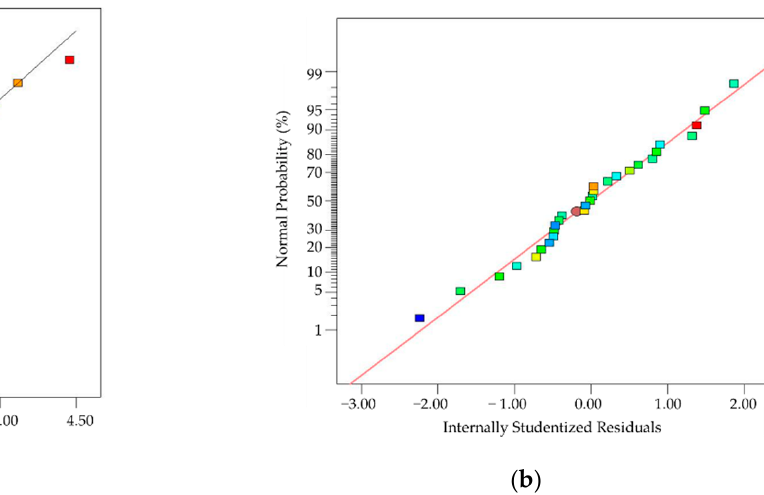
Figure 9. The detection plot of the regression model for the impurity rate. ( a ) Analysis of the predicted and actual values of the impurity rate. ( b ) The residual analysis of the impurity rate.